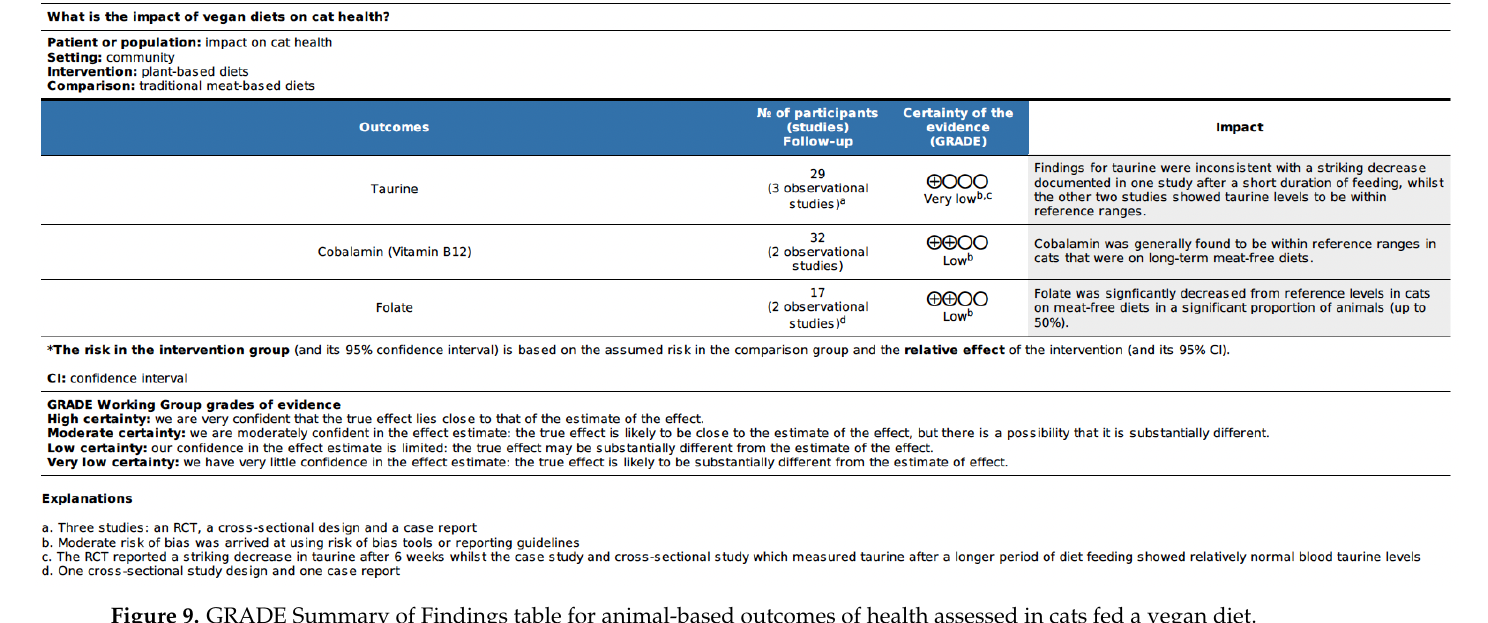
Figure 9. GRADE Summary of Findings table for animal-based outcomes of health assessed in cats fed a vegan diet.